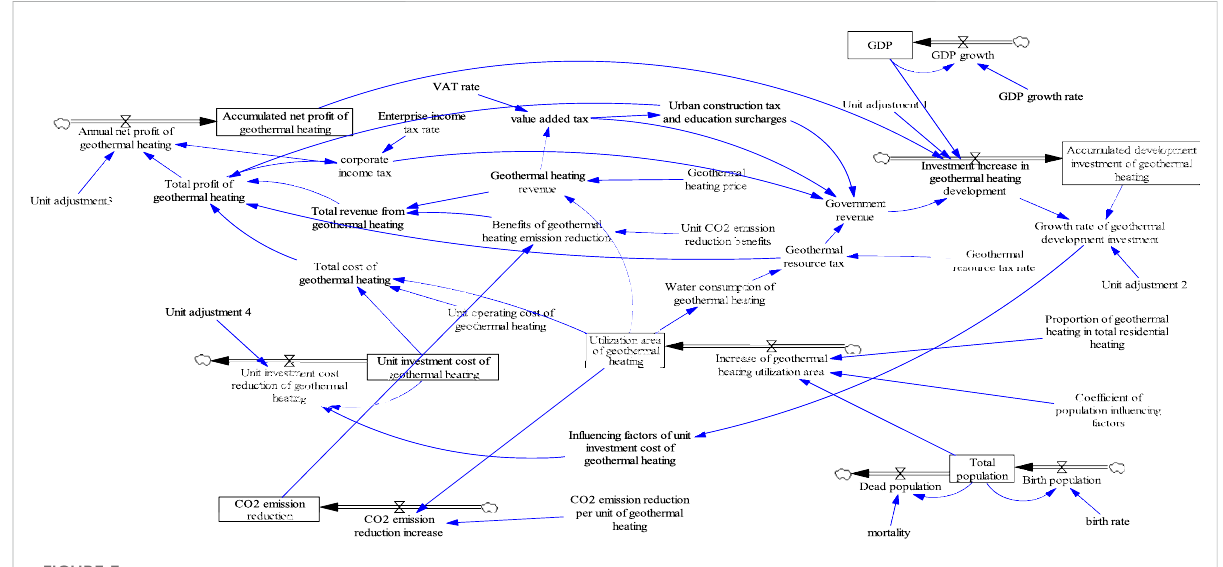
FIGURE 3 Geothermal resource tax system dynamics fl ow diagram in central heating